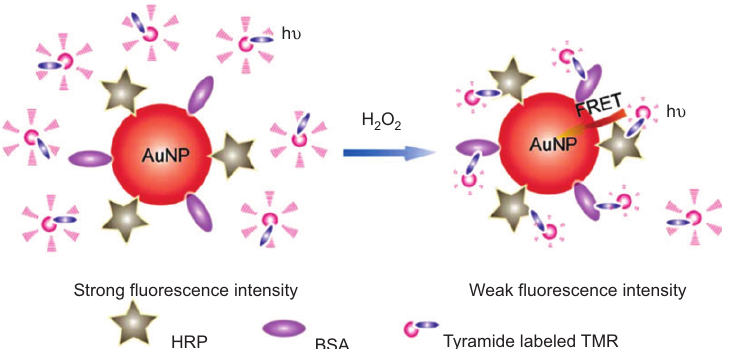
Figure 10 Schematic illustration for the FRET process between tyramide-labeled TMR (donor) and HRP-AuNPs (acceptor). From Ref. [106] .